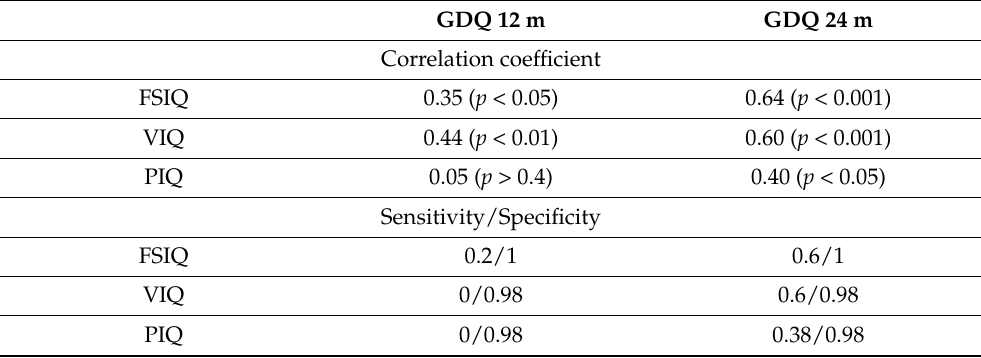
Table 5. Pearson correlation test between GMDS at 12–24 months and WPPSI